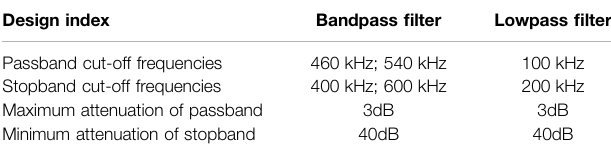
TABLE 2 | Designed Butterworth digital fi